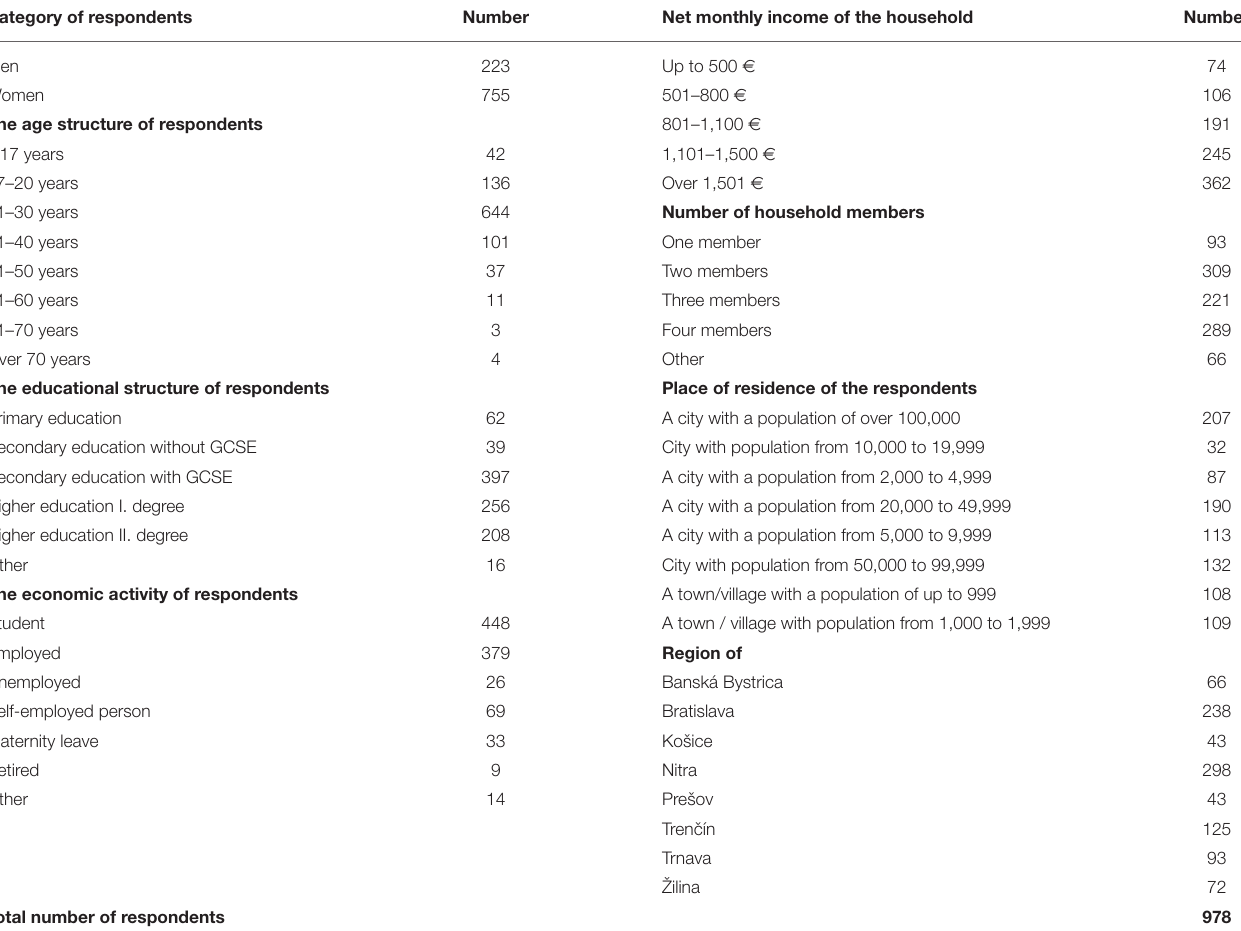
TABLE 1 | Characteristics of respondents.